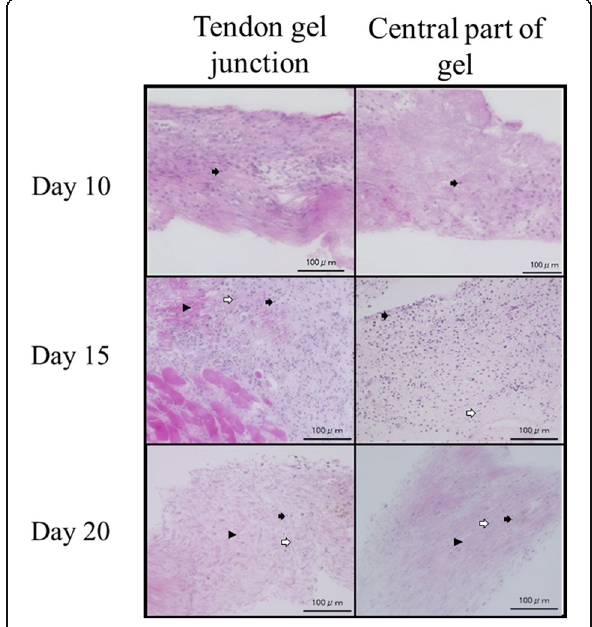
and eosin under a light microscope. Round cells, flat cells, and collagen fibers are observed. Collagen fibers are not observed in the day 10 group. Round cells are decreased at the central part of the tendon gel